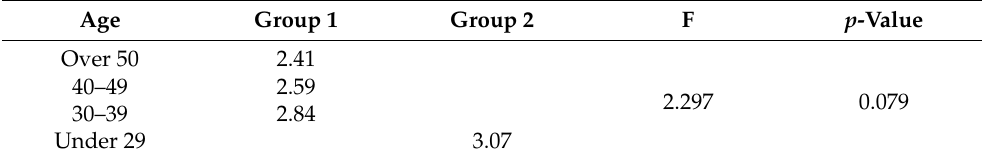
Table 5. Comparison of mean scores by